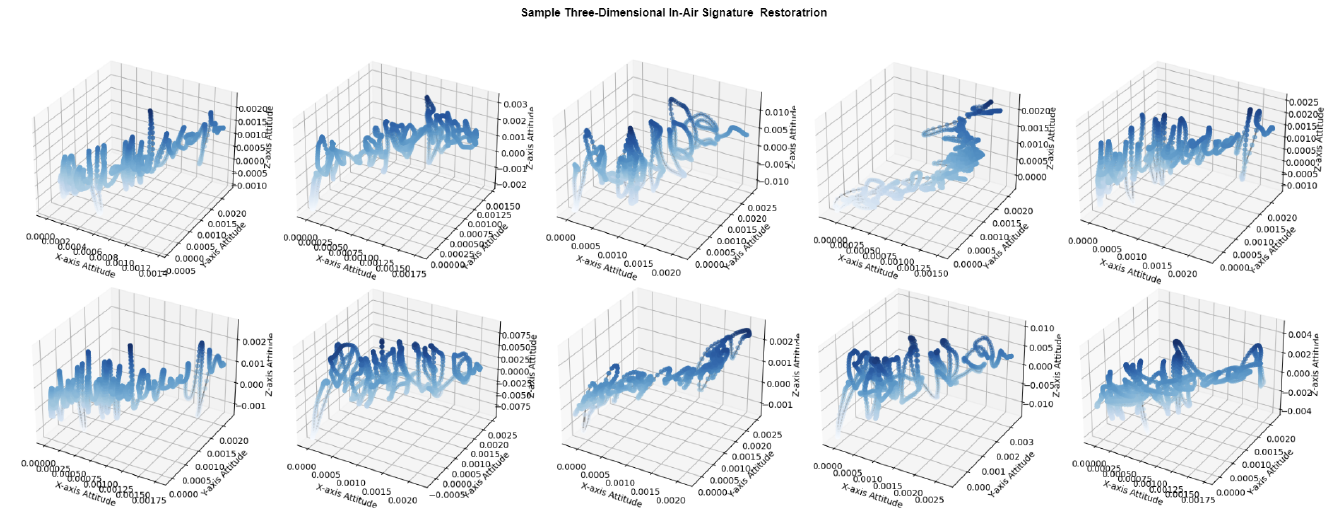
Figure 10. The in-air signature three-dimensional static restoration of a